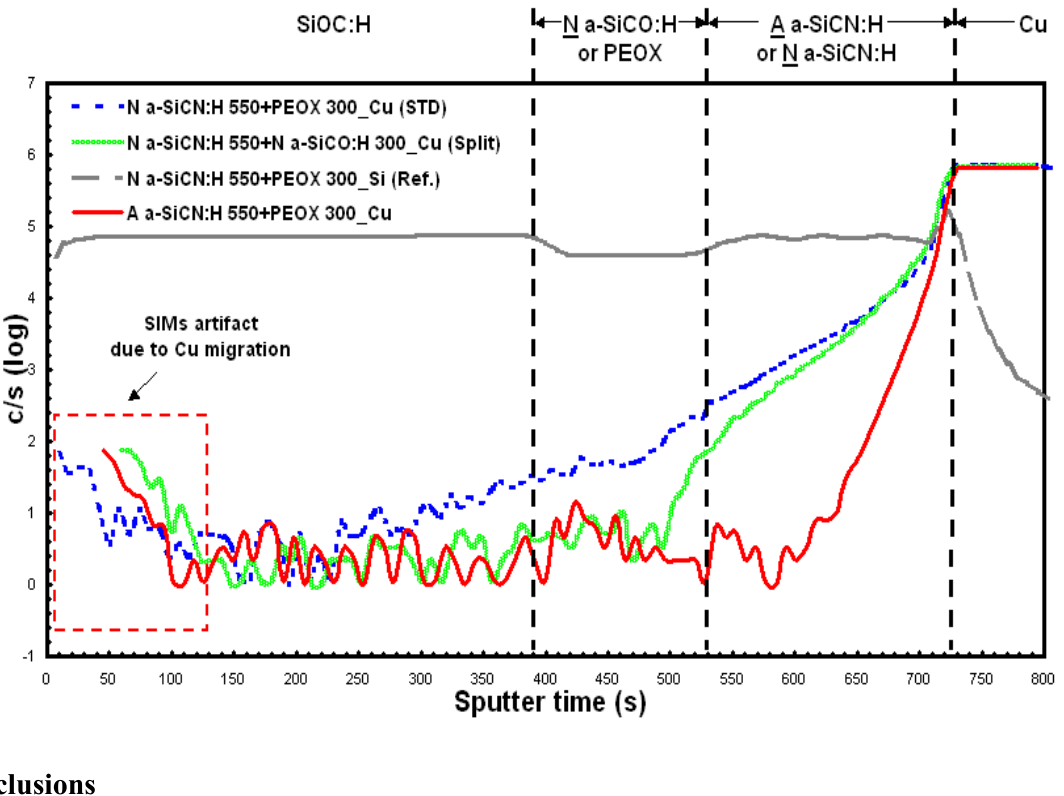
Figure 4. Second Ion Mass Spectroscopy (SIMs) depth profile of Cu in A α -SiCN:H 500+PEOX 300 Cu (red line), N α -SiCN:H 550+PEOX 300 (blue line), and N α -SiCN:H 550+ N α -SiCO:H 300 (green line) dual layer dielectric barrier